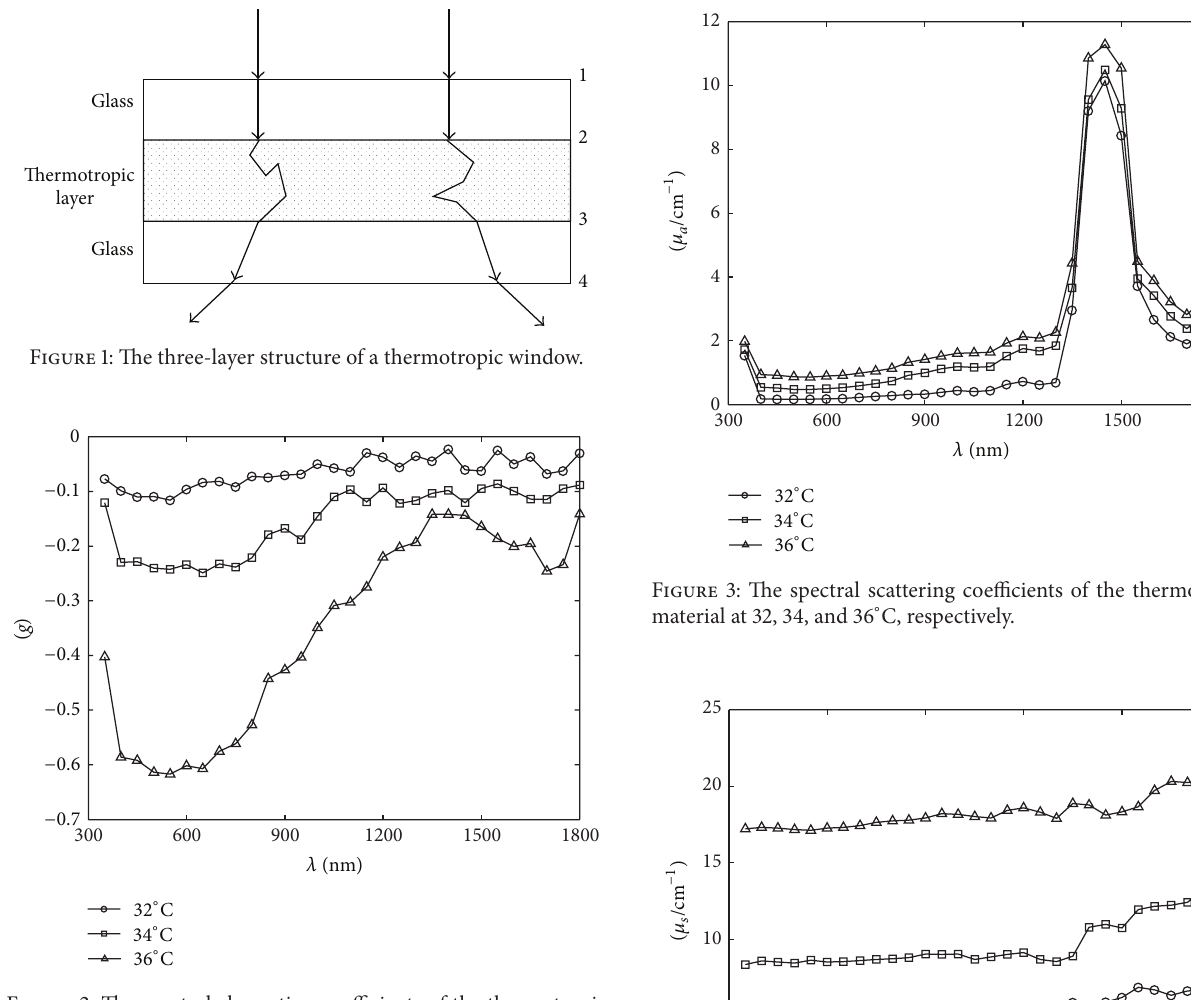
Figure 2: The spectral absorption coefficients of the thermotropic material at 32, 34, and 36 ∘ C, respectively.